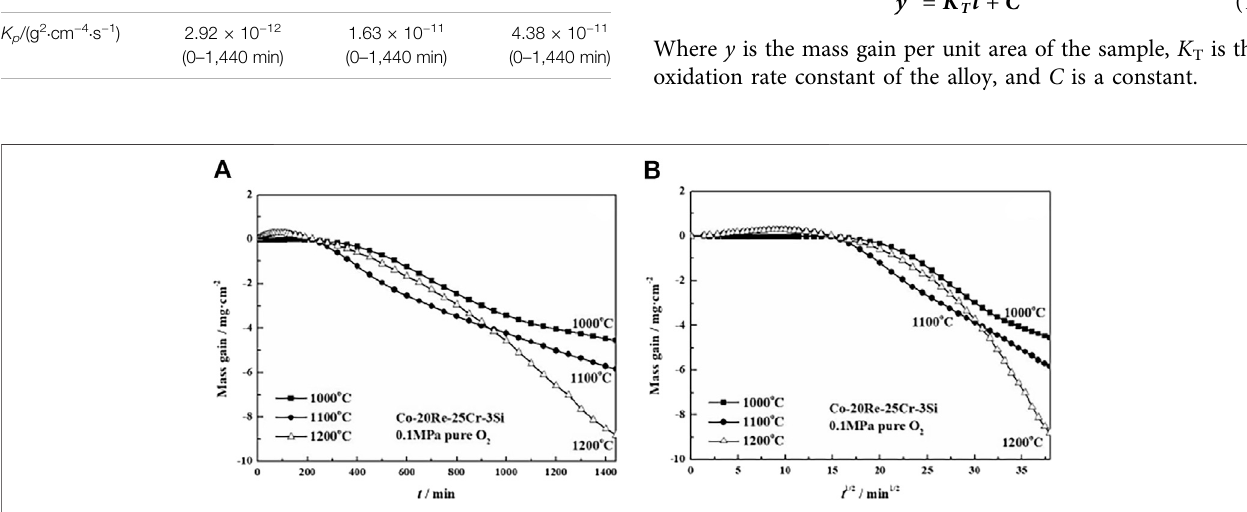
Frontiers in Materials |